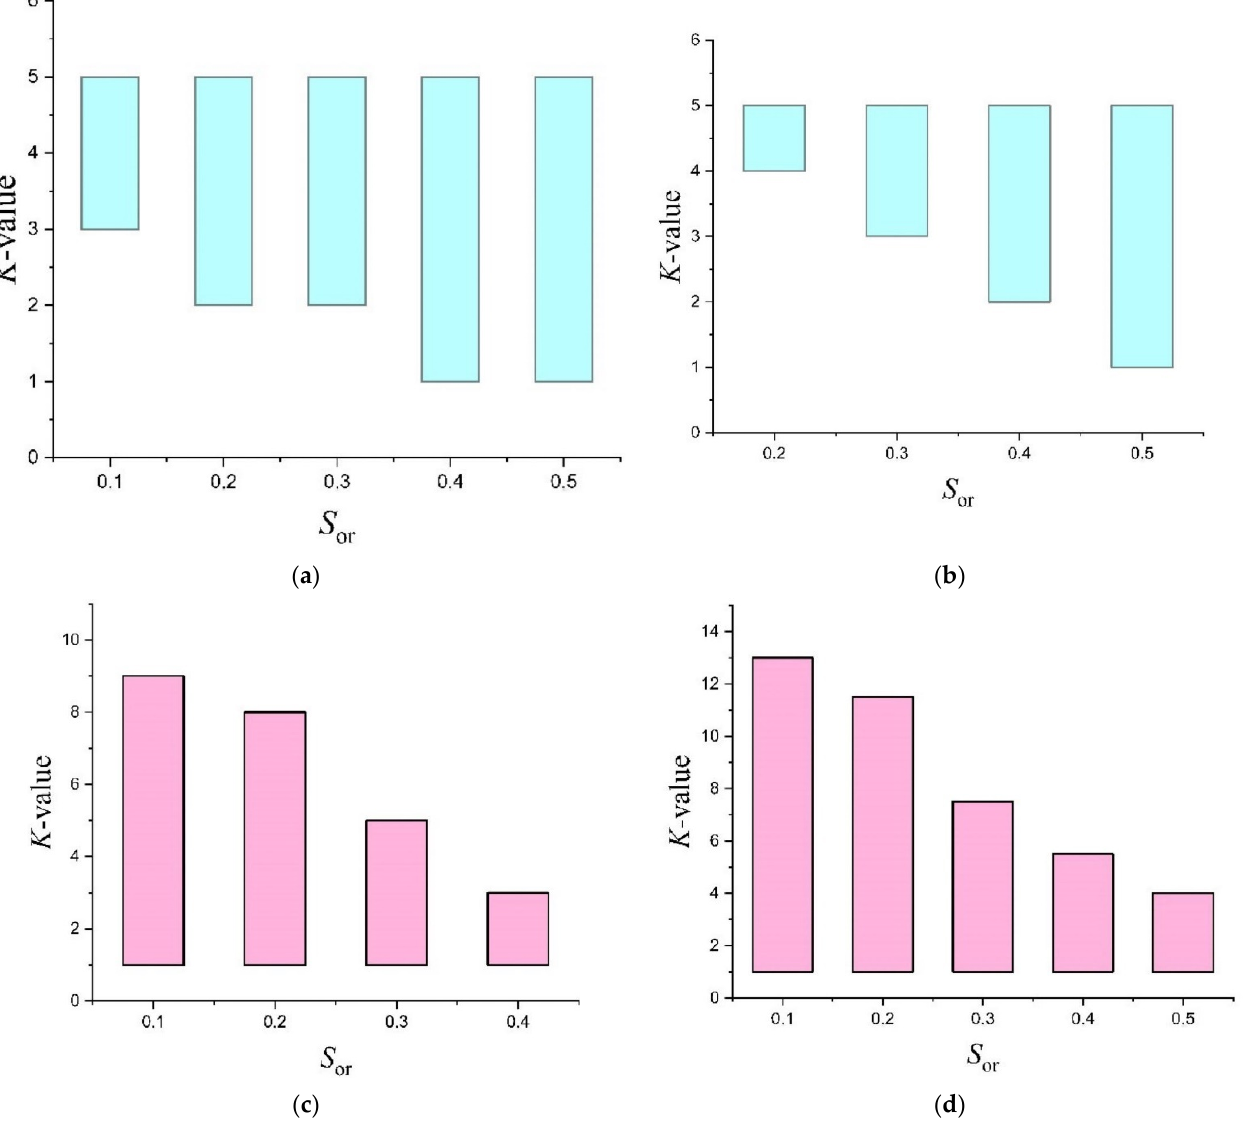
Figure 5. Range of K -values at different values of residual oil saturation S or and formation water salinity, leading to the optimal well shut-in time for ethyl formate: ( a ) T = 35 °C; ( b ) T = 45 °C and ethyl acetate: ( c ) T = 70 °C; ( d ) T = 90 °C.